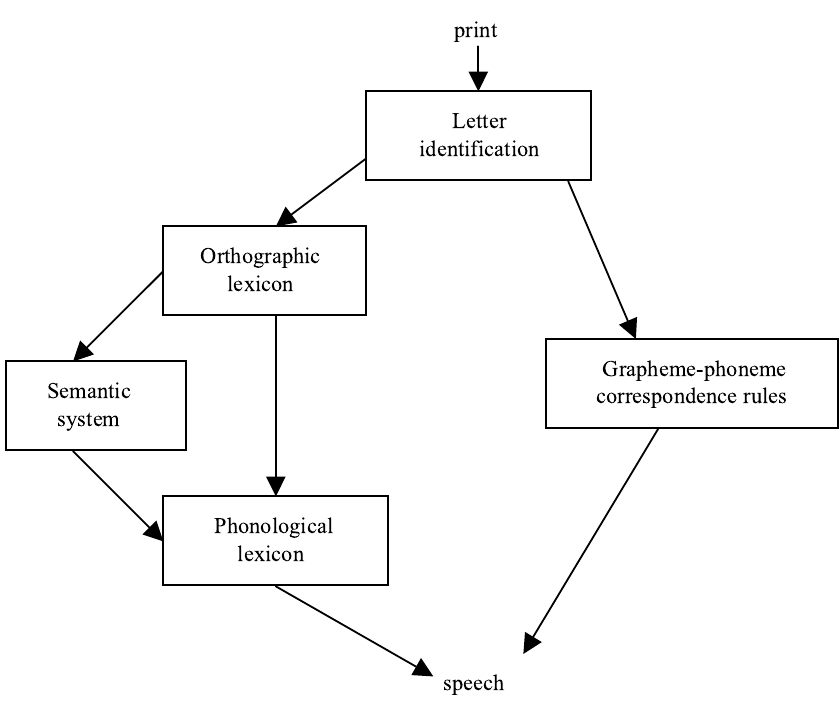
Figure 2. Elaboration of the dual-route theory of reading